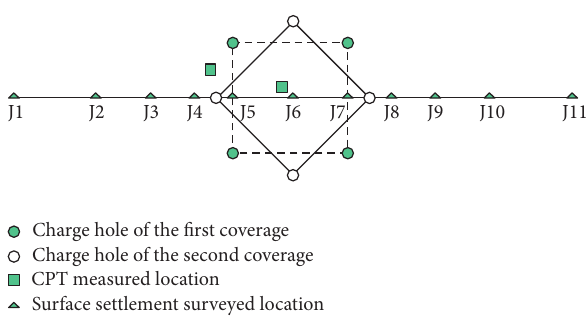
Figure 7: Sketch of charge hole, settlement surveyed, and CPT measured location in plan